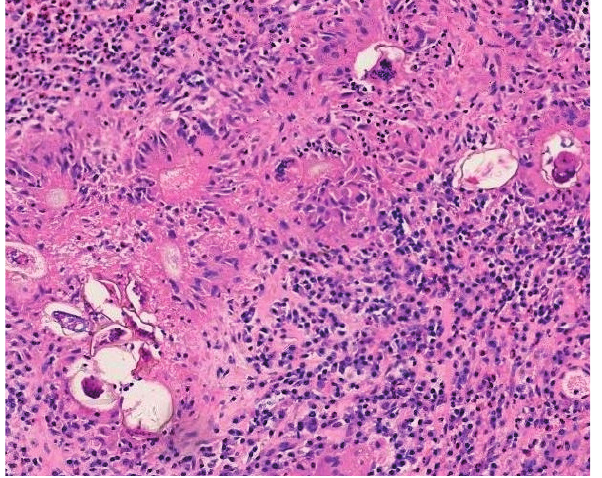
Fig. 3. Axial MR T1WI post contrast revealing a cluster of intensely enhancing nodules within the mass, each measuring approximately 1 - 3 mm in size. Some of the nodules appear to have coalesced together, creating a confluent enhancing lesion. Also noticeable are subtle regions of linear or slit-like enhancement surrounded by closely packed nodules, creating an arborising